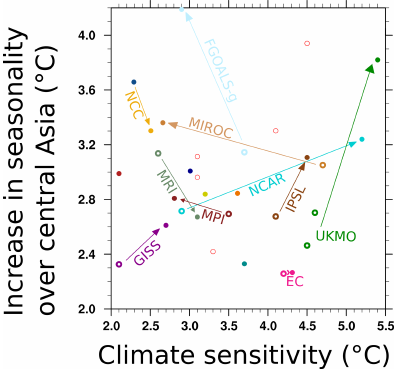
Figure 12. The relationship between equilibrium climate sensitiv- ity and increasing seasonality over central Asia. The seasonality is computed as the mean temperature of the warmest month minus the mean temperature of the coldest month, averaged over 30–50 ◦ N, 60–75 ◦ E (Christensen et al., 2013). The shifts between different generations of models are indicated and labelled after their mod- elling group (NCAR developed both CCSM4 and CESM2; NCC developed NorESM1-F and NorESM2-LM; and UKMO developed HadGEM2-CC, HadGEM2-ES, and